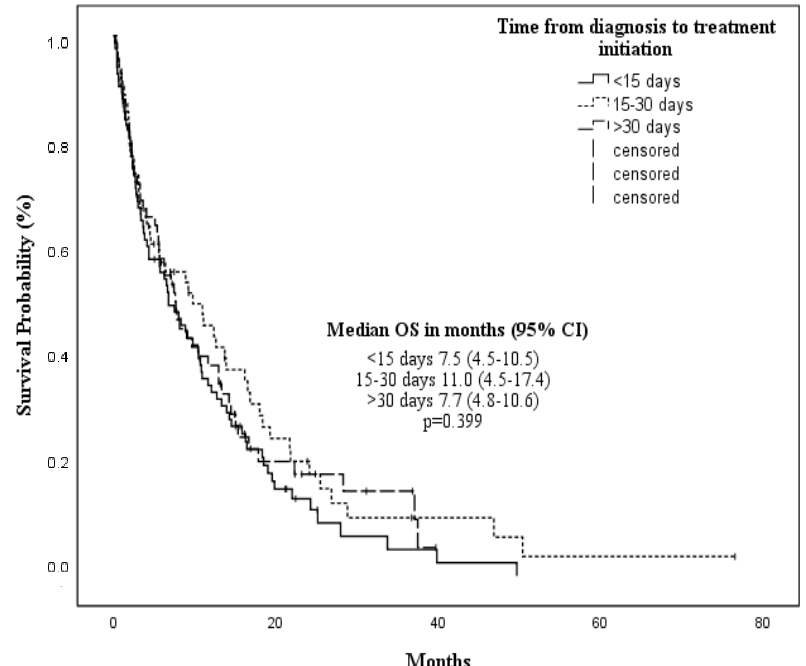
Figure 3. Median overall survival according to time from diagnosis to treatment initiation (≤15